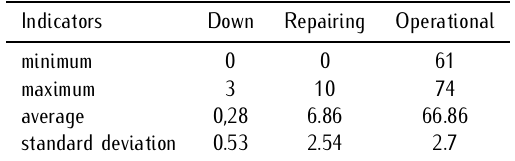
Table 2. Output operating statistics for the considered simulation